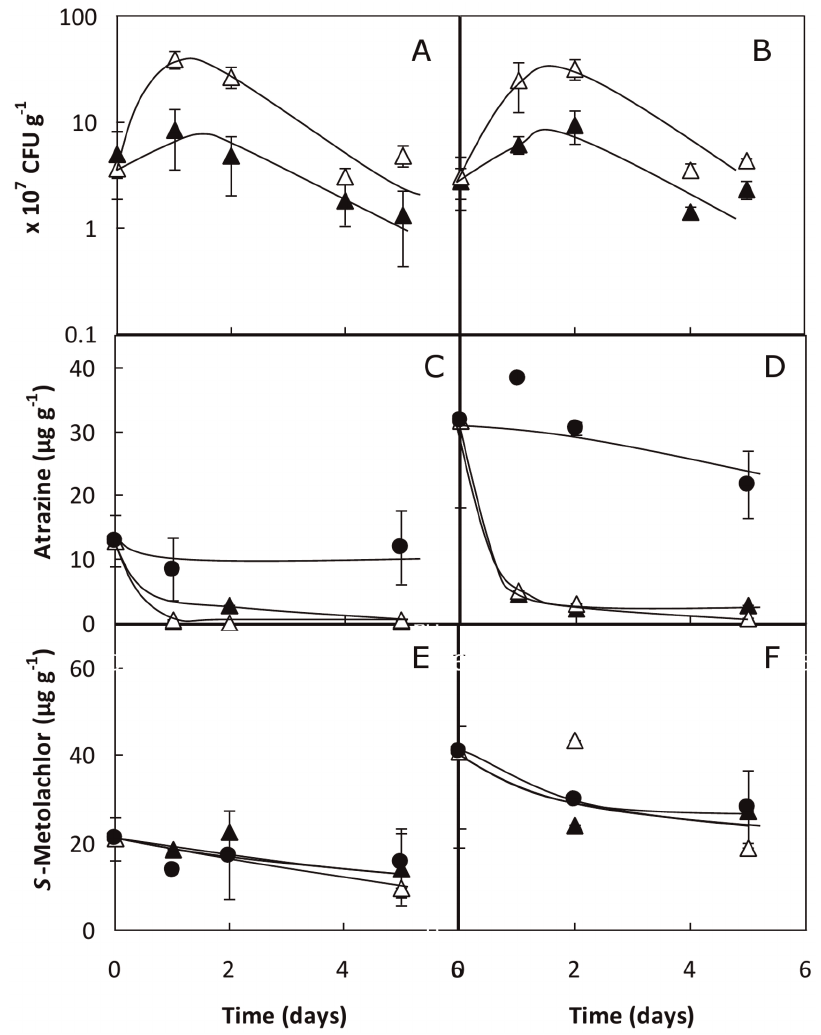
Figure 3. Biodegradation of ATZ from Primextra S -Gold and fate of S -MET in larger soil microcosms. Time-course variation of ( A, B ) the concentration of viable cells of Pseudomonas sp. ADP Rif R , ( C, D ) the average concentration of ATZ and ( E, F ) the average concentration of S -MET, in the soil microcosms contaminated with ( A, C, E ) 20 6 RD or ( B, D, F ) 50 6 RD of Primextra S-Gold, and bioaugmented with Pseudomonas sp. ADP with ( D ) or without ( m ) citrate amendment, during incubation at 25 u C. ATZ and S -MET concentrations in the non-inoculated control soil ( shown in (C, D) and (E, F), respectively, for comparison. Data are means 6 SD of measurements from at least two replicated samples from two independent experiments under each